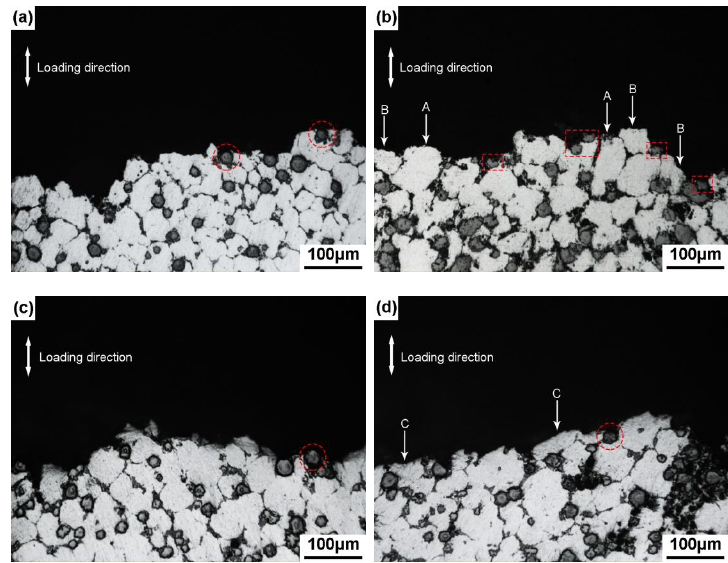
Figure 11. Fractographs of the composites thixoformed at mold temperatures of ( a ) 150 °C, ( b ) 200 °C, ( c ) 300 °C, and ( d ) 400 °C.